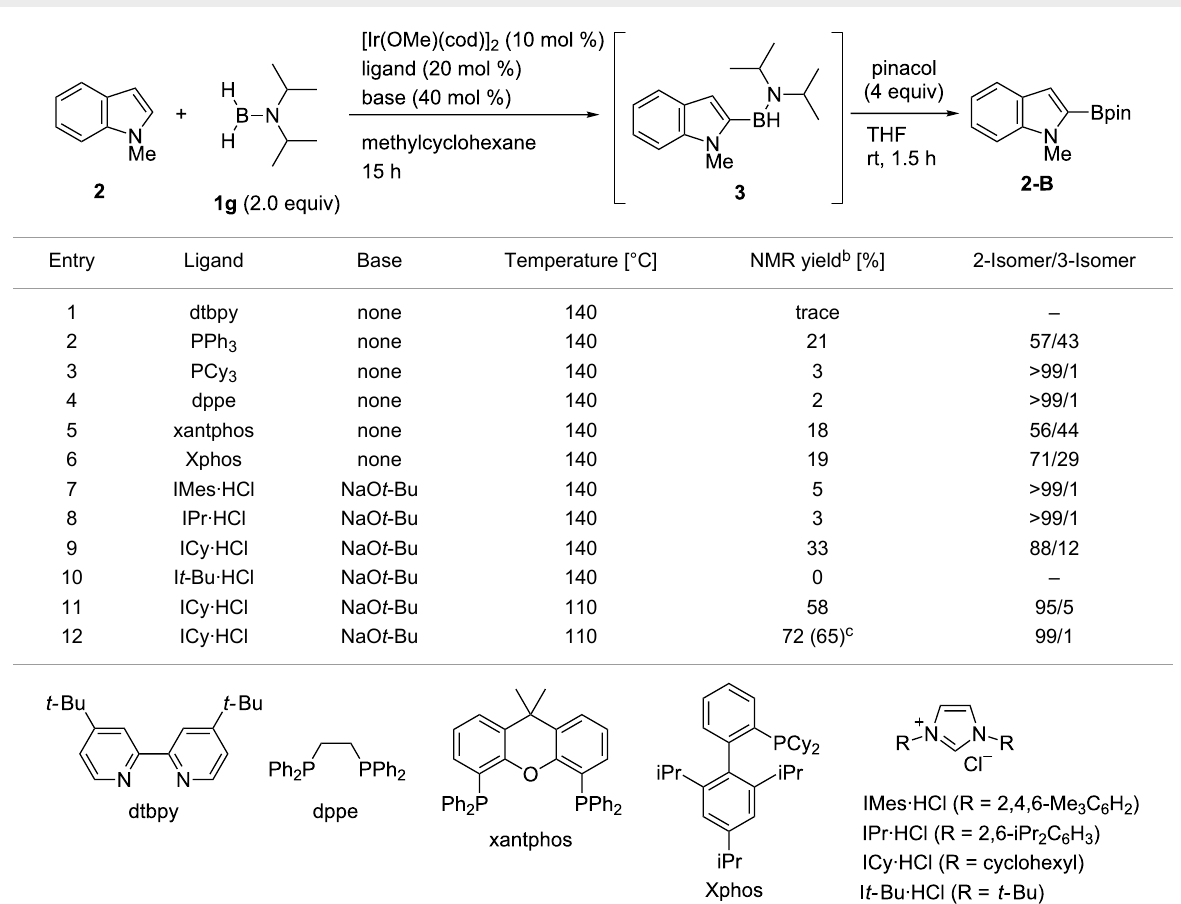
Table 1: Effect of the ligand on the Ir-catalyzed borylation of 2 with 1g . a